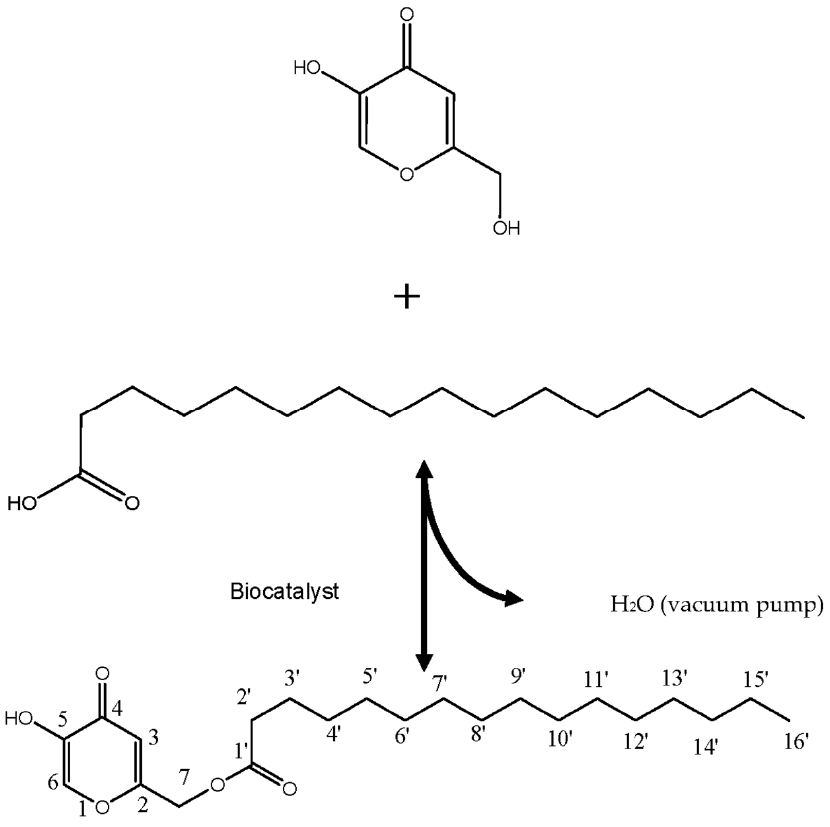
Figure 6. Reaction scheme and molecular structure of 7- O -kojic acid monopalmitate (7- O -KAP).